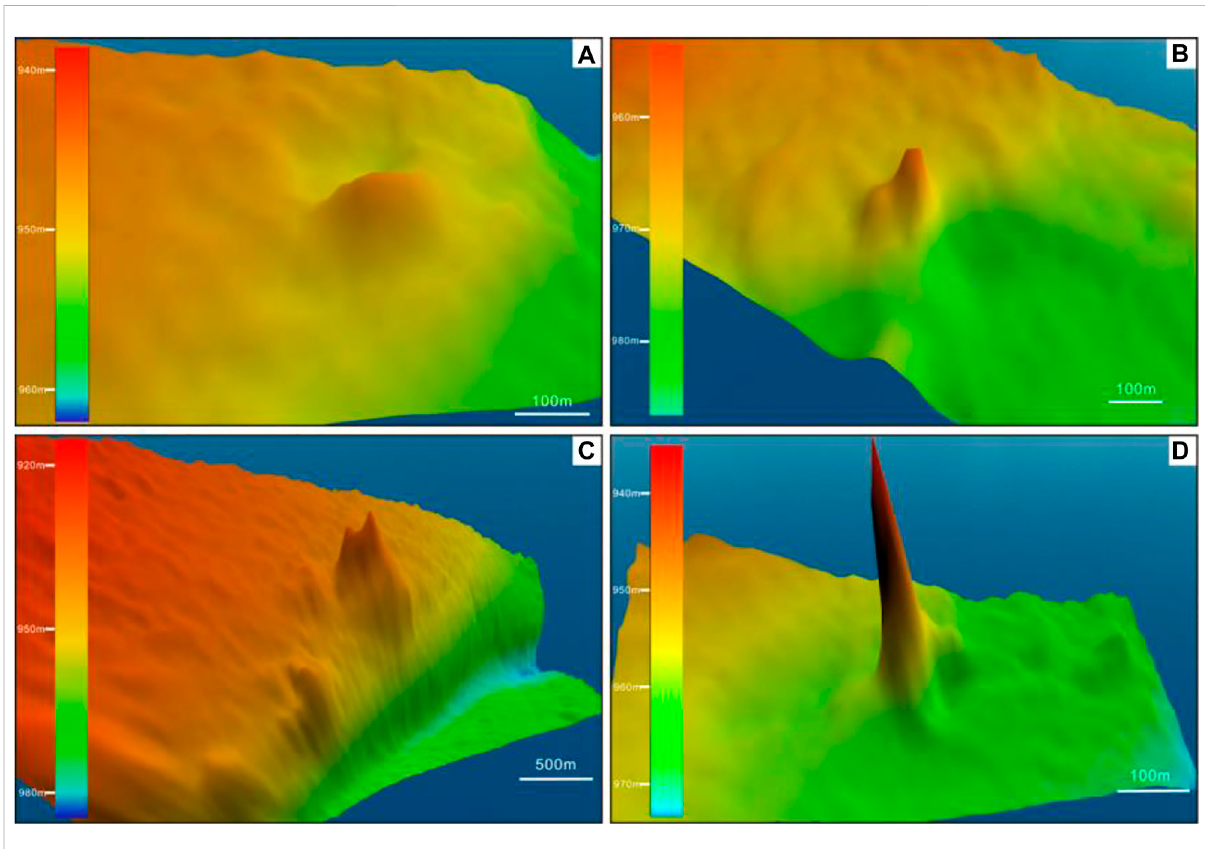
FIGURE 8 Multibeam dataofdomes. (A) Anexample ofatype-Adome,which has fl atedi fi ceswith gentle slopesontheircrests; (B) and (C) Twoexamples oftype-Adomes,whichhaveanirregularshape; (D) Anexampleofatype-Cdome,whicharemoreconicalwitharelativelysteepslope.Seelocations in Figure